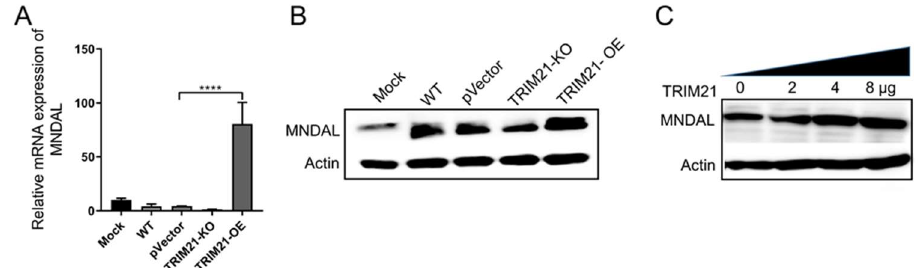
Figure 6. Porcine TRIM21 increases porcine MNDAL expression. ( A , B ) Cells were infected with PCV2 for 72 h, followed by qRT-PCR ( A ) and Western blot ( B ). ( C ) HEK293T cells in the 6-well plate were co-transfected with pIRES2-EGFP-TRIM21 (0, 2, 4, and 8 μg) and pEGFP-MNDAL-N1 (0.5 μg) for 48 h, followed by Western blot. Mouse MNDA antibody (1:500) and mouse anti-β-actin antibody (1:2000) was used as the primary antibody, HRP-labeled goat anti-mouse IgG (H + L, 1:2000) was used as the secondary antibody. **** p < 0.0001. The copies of MNDAL mRNA were normalized with GAPDH. Unprocessed original images can be found in Supplementary Figure S6.